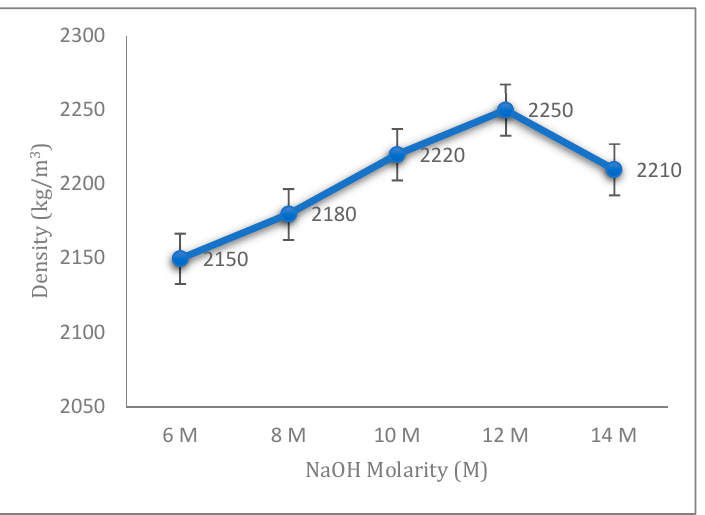
Figure 3. Density of the fly ash geopolymer aggregate with different molarities of NaOH.